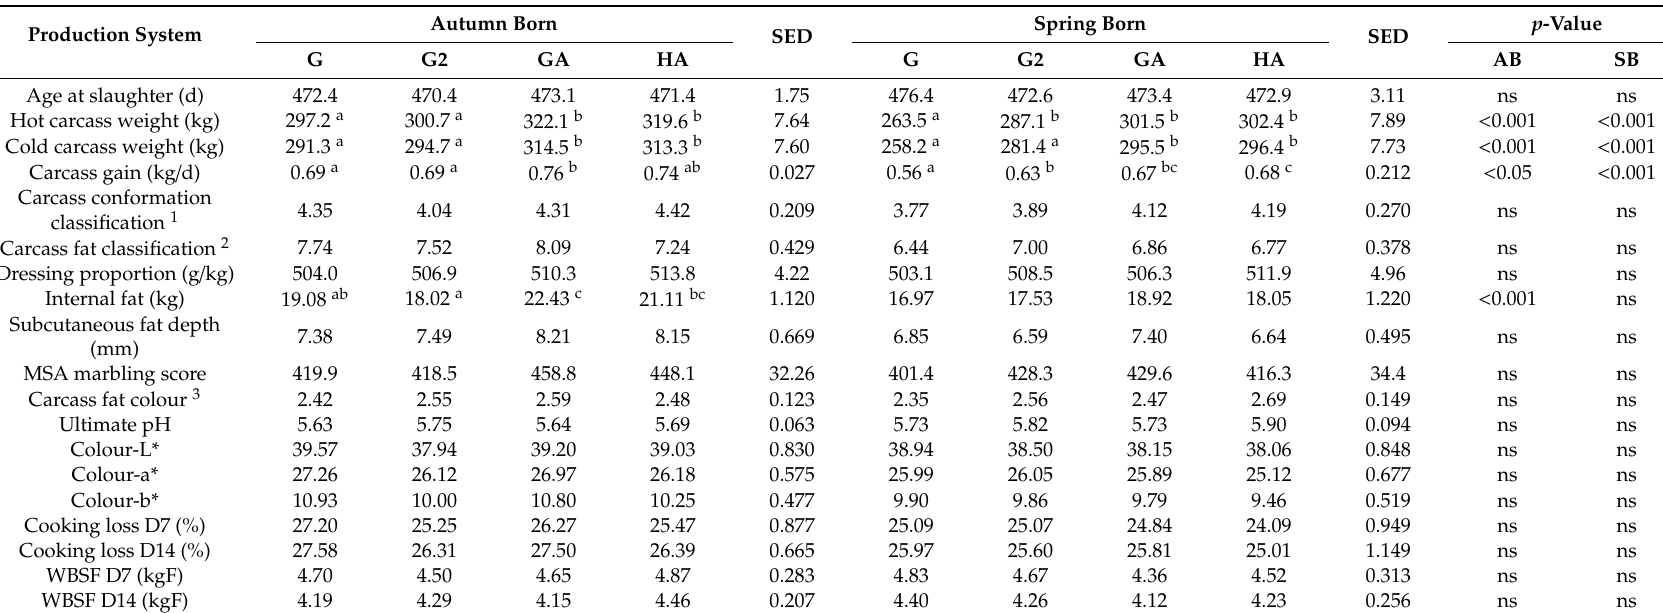
Table 5. Mean carcass characteristics and meat quality of autumn and spring born bulls on four production